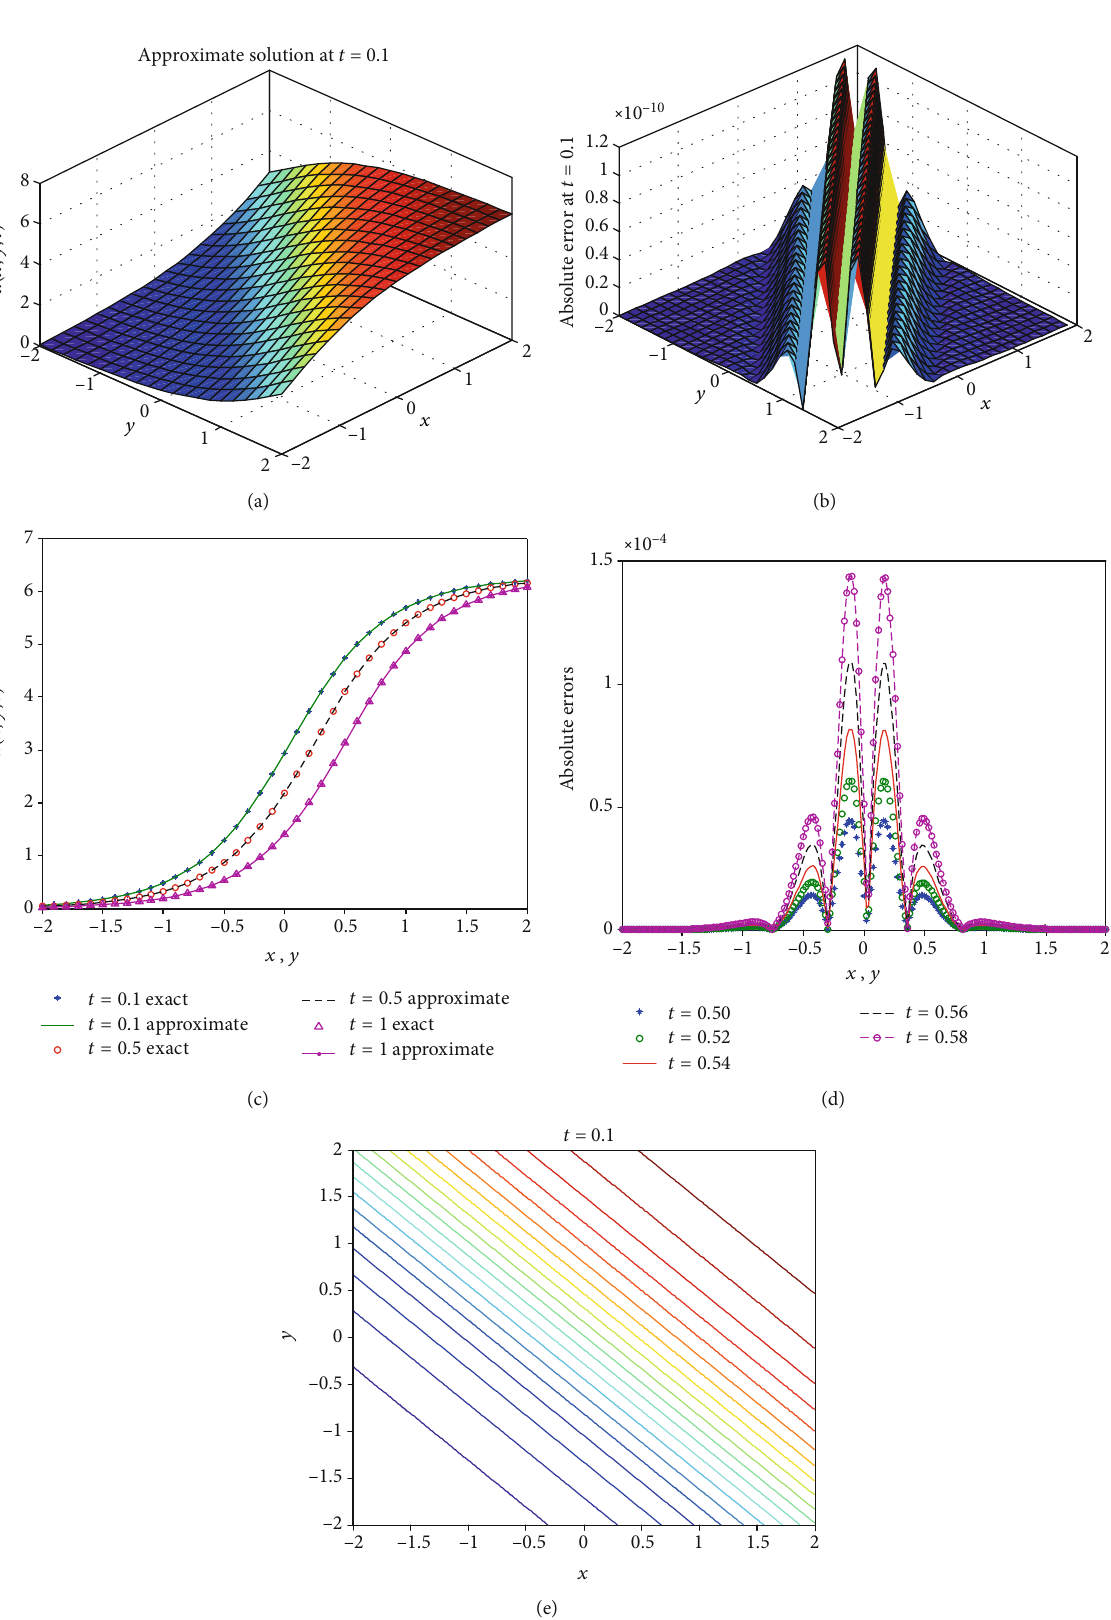
Figure 4: Plots of the solution behavior of Example 4: (a) approximate solution at t = 0 : 1 ; (b) absolute error t = 0 : 1 ; (c) comparison of exact and approximate solutions for times t = 0 : 1 , 0.5, 1; (d) comparison of absolute errors for di ff erent values of times t = 0 : 5 , 0.52, 0.54, 0.56, 0.58; and (e) the soliton at t = 0 : 1